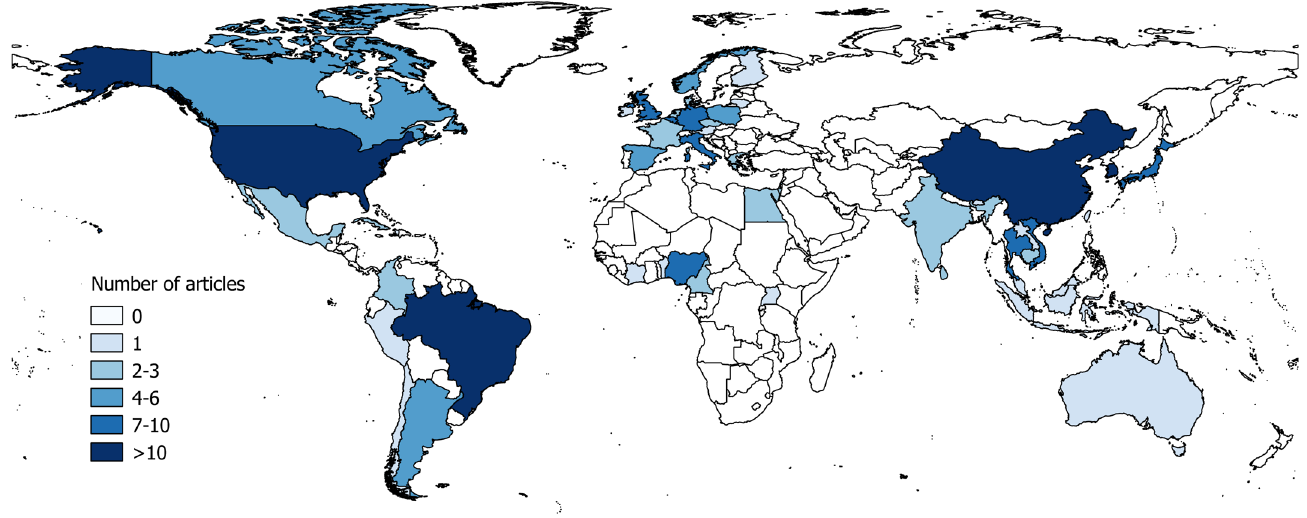
Fig 2. Map of the number of included articles by country. N = 217 articles overall; some articles reporteddata from severalcountries.